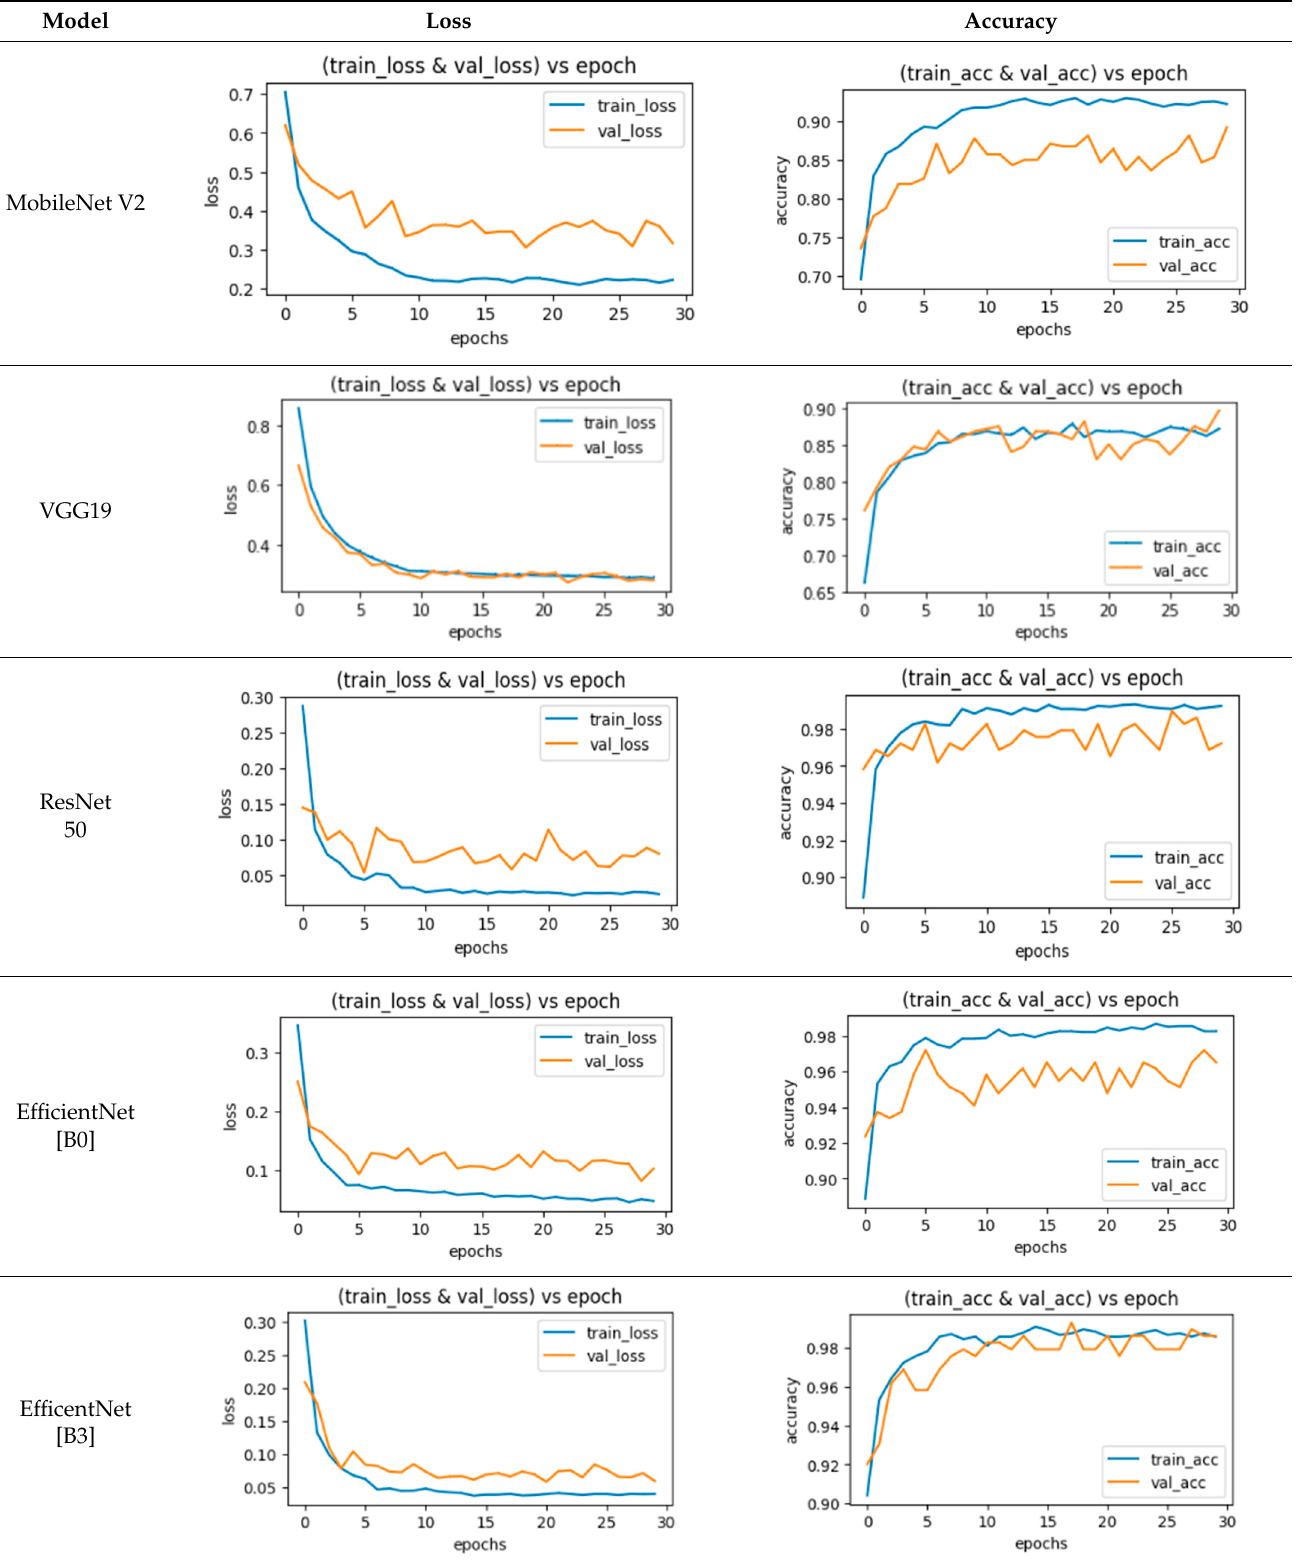
Table 4. Performance analysis of the training process for deep learning models with real-time dataset collection.